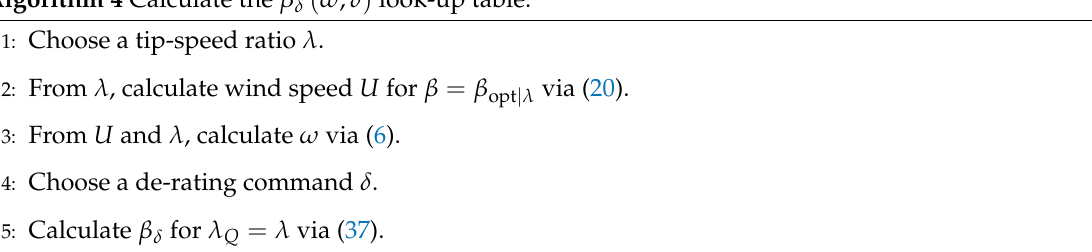
Algorithm 4 Calculate the β δ ( ω , δ ) look-up